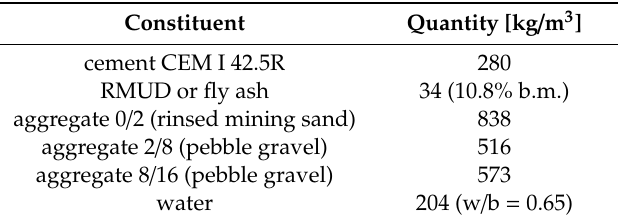
Table 2. Composition of tested